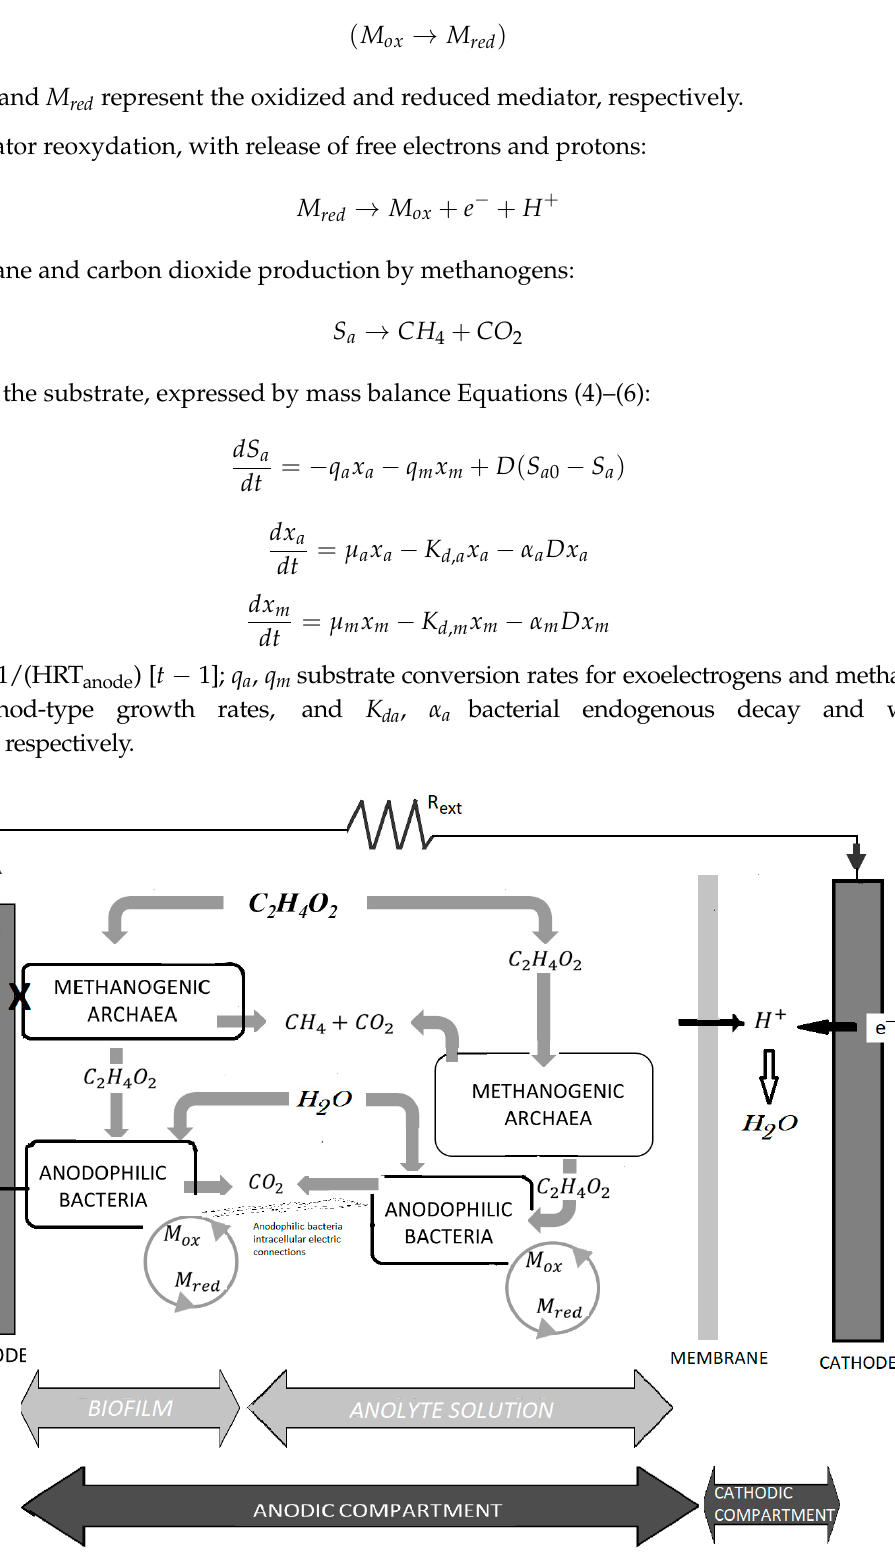
Figure 1. The initial conceptual model.